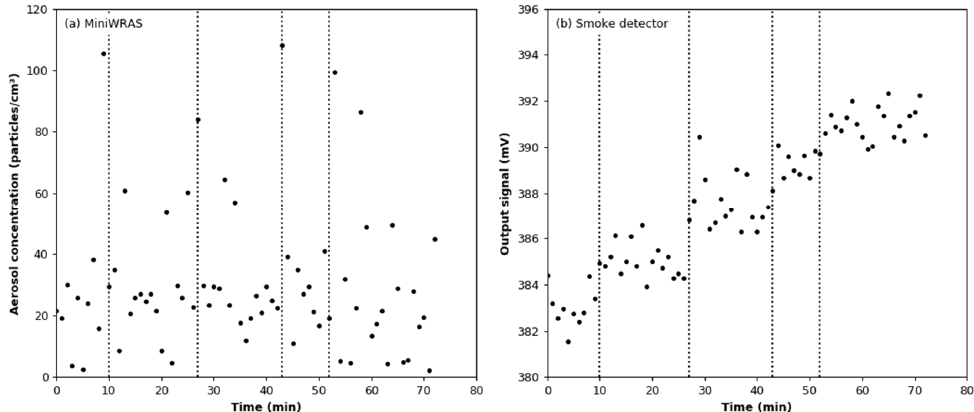
Figure 9. Readings from aerosol detectors during argon additions: ( a ) total number concentrations measured by the MiniWRAS; ( b ) output signal from the smoke detector.